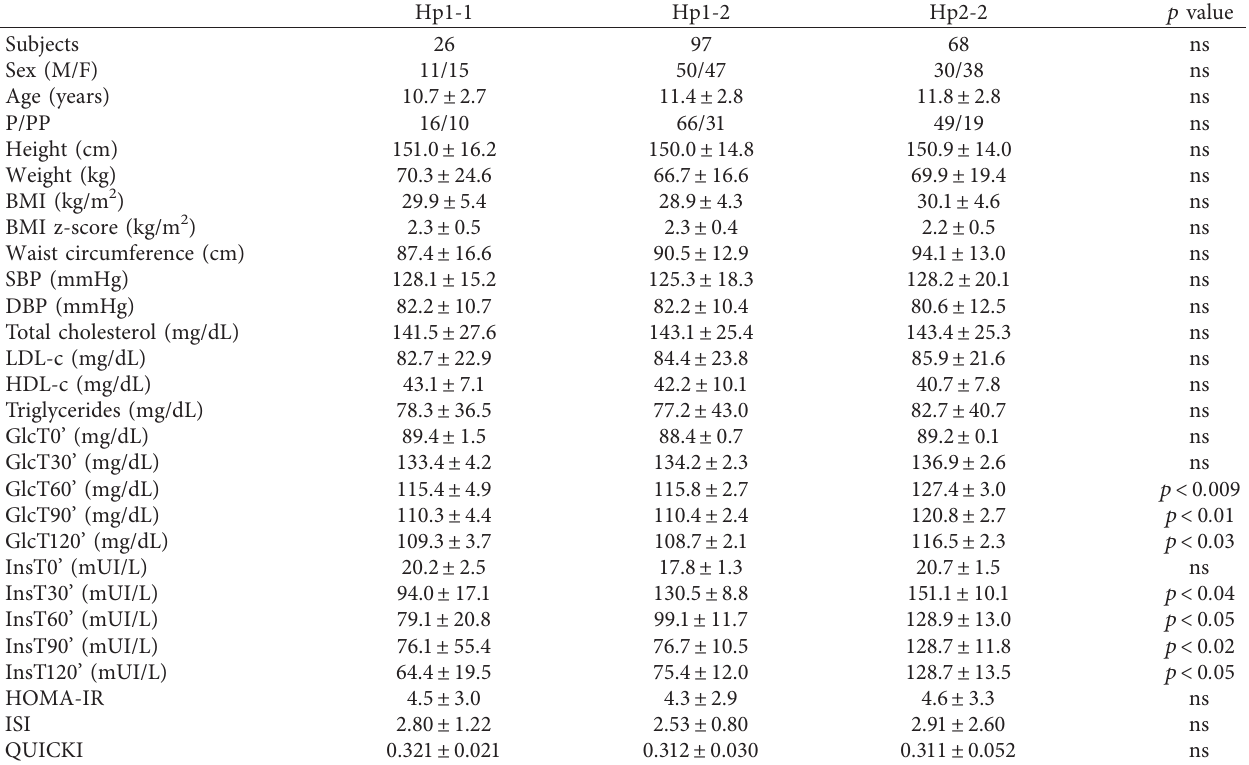
Table 2: Clinical and biochemical characteristics according to each HP phenotype.